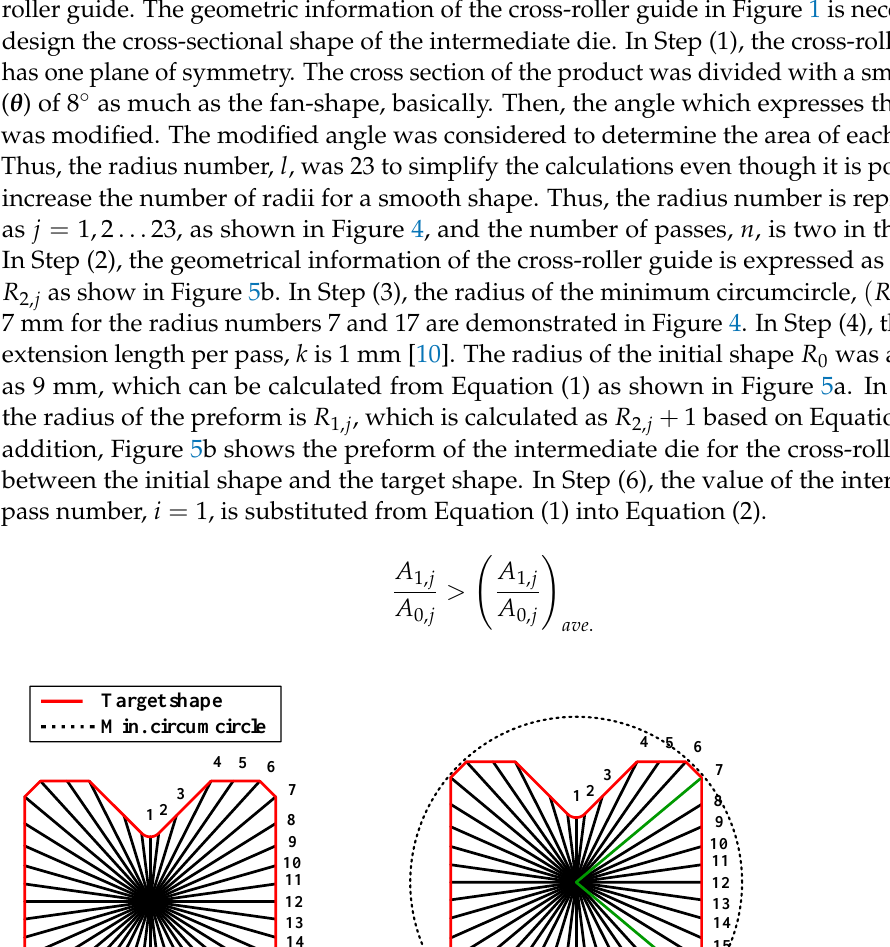
Figure 5. ( a ) Initial and target shapes of the cross-roller guide and ( b ) preform of the cross-roller guide. Table 1 shows the value of 𝑅 2,𝑗 , 𝑅 1,𝑗 , 𝐴 1,𝑗 /𝐴 0,𝑗 , (𝐴 1,𝑗 /𝐴 0,𝑗 ) 𝑎𝑣𝑒. , and 𝑅 ′ 1,𝑗 of the cross- roller guide. Figure 6 shows the intermediate die shape of the cross-roller guide, which is determined by using the ERV method and the shape of the second pass die is equal to the target shape. 𝑅 ′ 1,𝑗 has a maximum value when 𝑗 is 7 or 17. Thus, when 𝑗 is 7 or 17 and 𝑘 is 0.9, 𝑅 0 is 8.8 mm and 𝑅 ′ 1,7 is 8.9 mm. When 𝑗 is 7 or 17 and 𝑘 is 0.8, 𝑅 0 is 8.6 mm and 𝑅 ′ 1,7 is 8.91 mm. Therefore, when 𝑘 is lower than 1, an undercut occurs and the size of the initial round bar, ø17.6 and ø17.2, were not manufactured with a commercial material. It is easy to get the size, ø18, of the initial rod for the shape drawing experiment when 𝑘 is 1. Therefore, the initial rod was determined as 9.1 mm, which is larger than maximum value of 𝑅 ′ 1,𝑗 . Table 1. ERV method for the cross-roller guide ( (𝐴 1,𝑗 /𝐴 0,𝑗 ) 𝑎𝑣𝑒. = 0.56 ). j 𝑹 𝟐,𝒋 (mm)